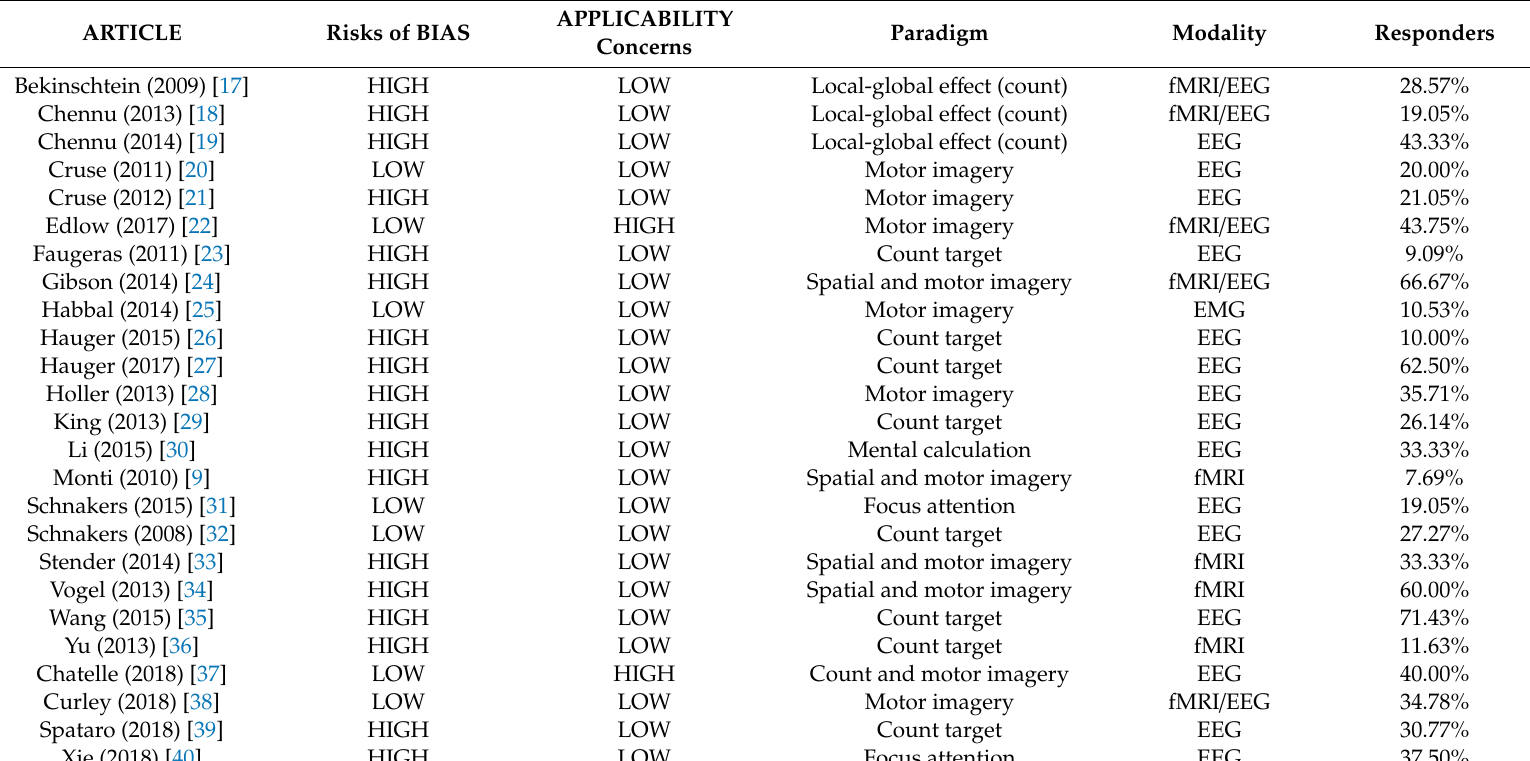
Table 1. Description of the studies included in our